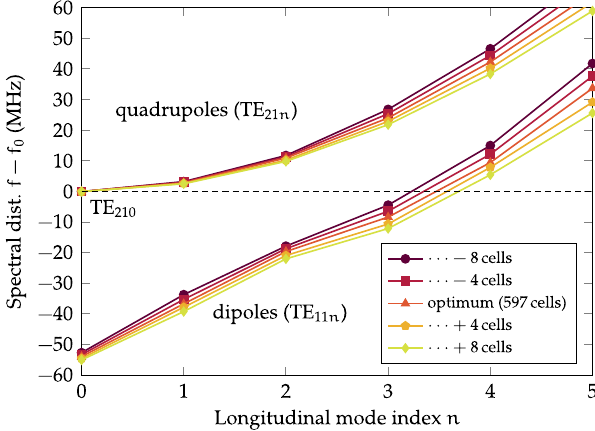
FIG. 18. Sensitivity of the eigenmode spectrum of RFQ1 with respect to its length, given as the number of accelerating cells.